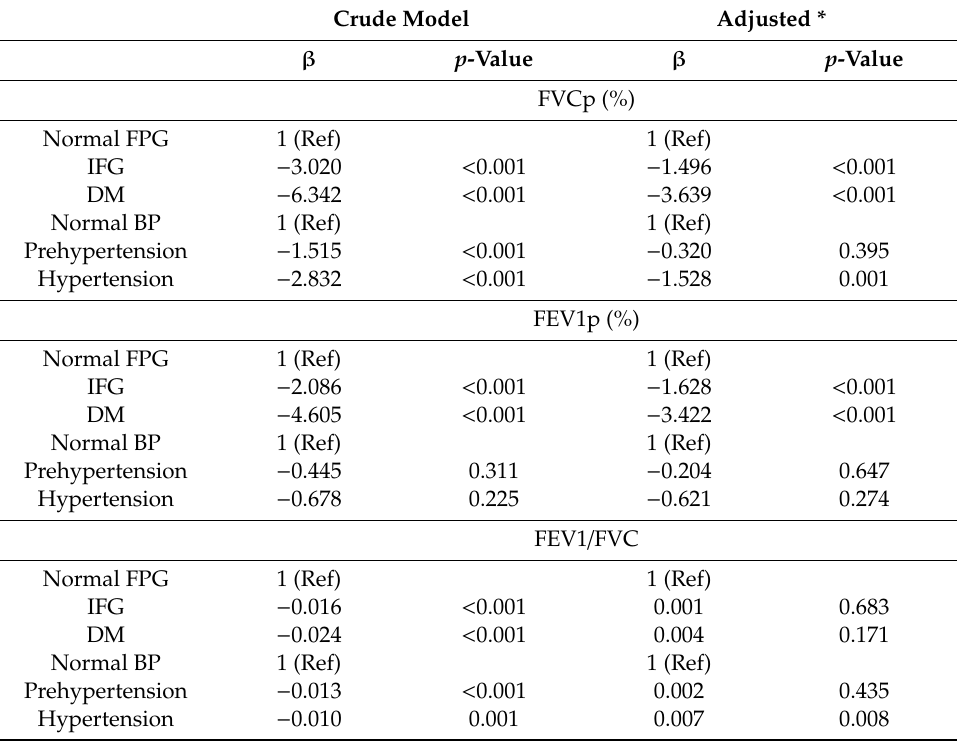
Table 2. Association between blood pressure, glycemic status, and pulmonary function using a multivariate linear regression